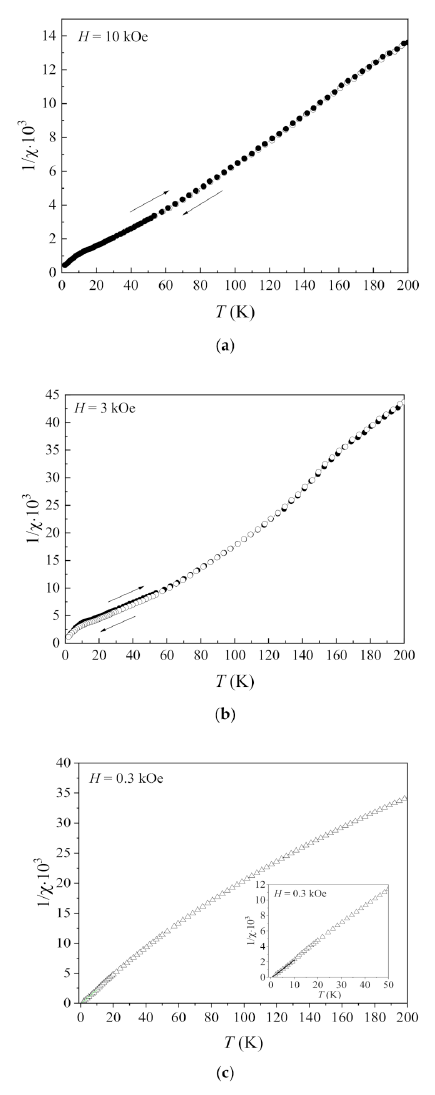
Figure 5. Temperature dependences of the inverse magnetic susceptibility: ( a ) for the nanocomposite sample measured in the field of 10 kOe; ( b ) for the nanocomposite sample measured in the field of 3 kOe; ( c ) for the bulk sample measured in the field of 0.3